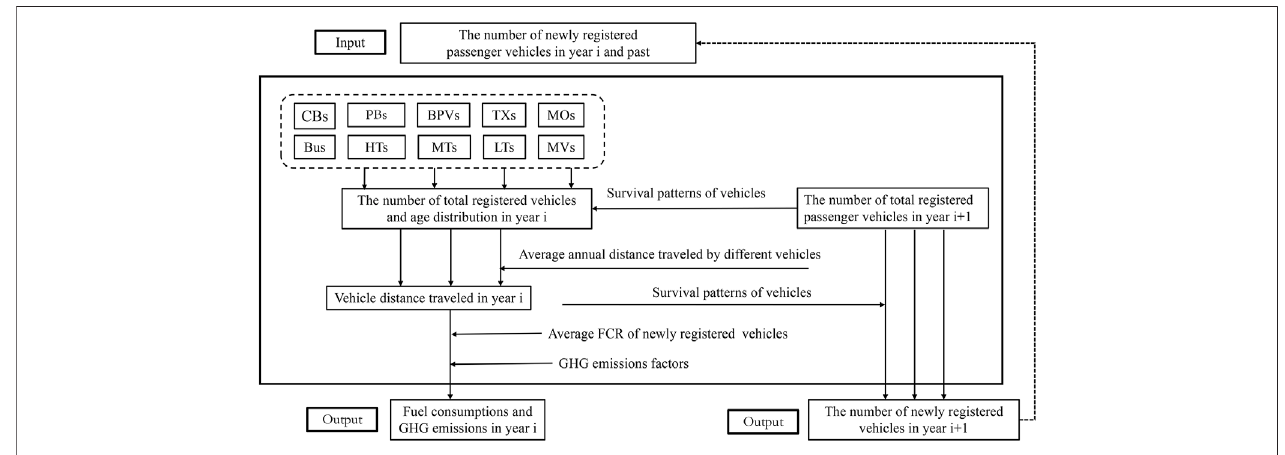
FIGURE 3 | Diagram of ownership model